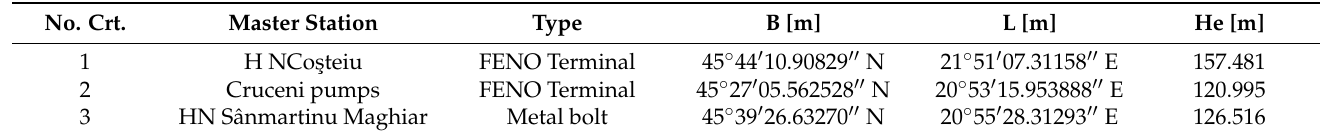
directly into the field or office (Table 1). Table 1. Master station coordinates for targets scanned in the WGS 1984 system.